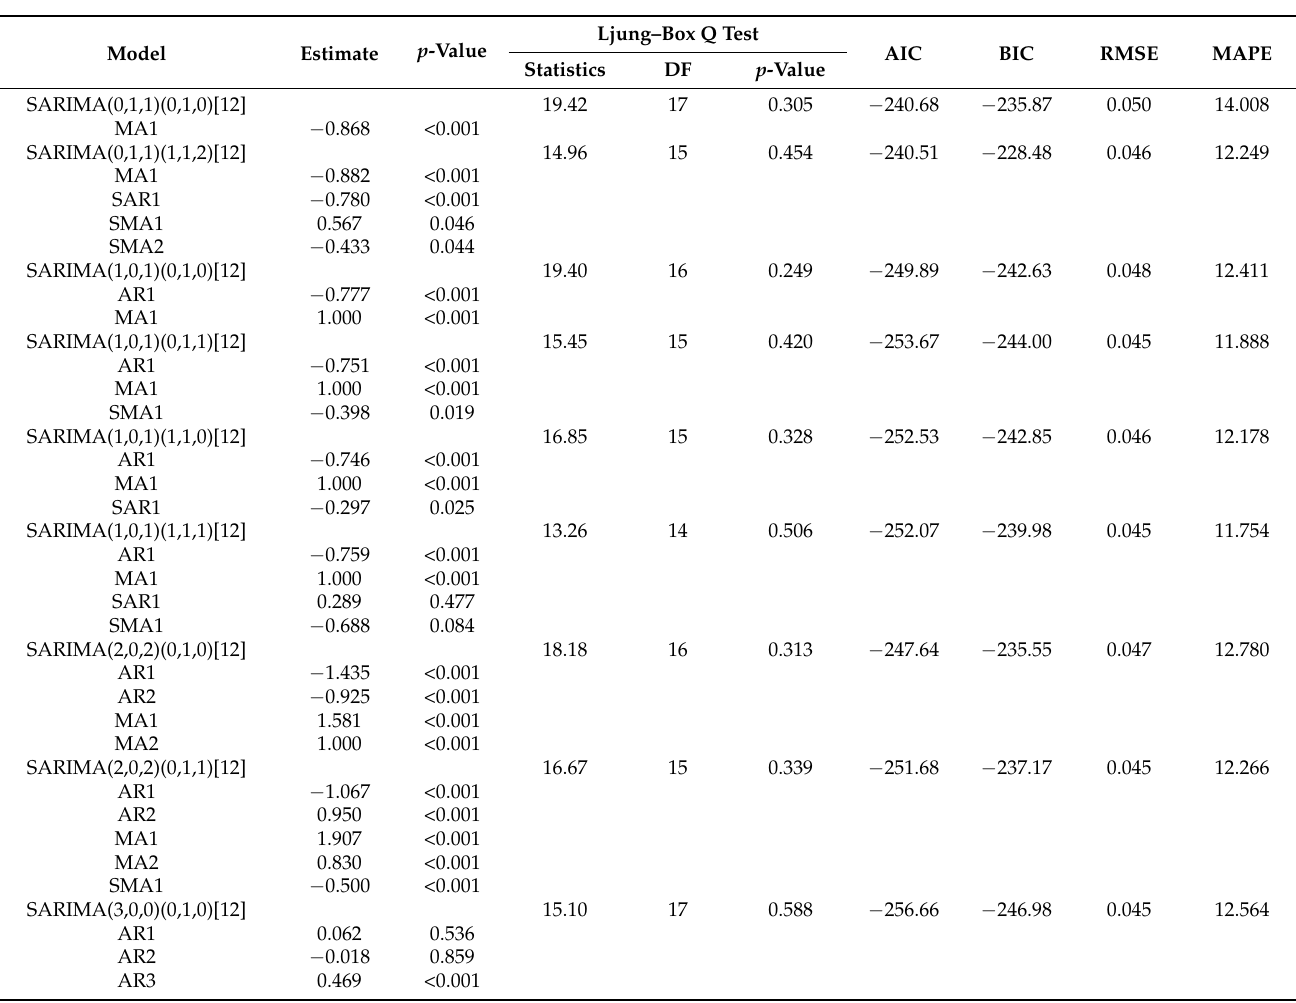
Table 1. Comparison of candidate SARIMA models.